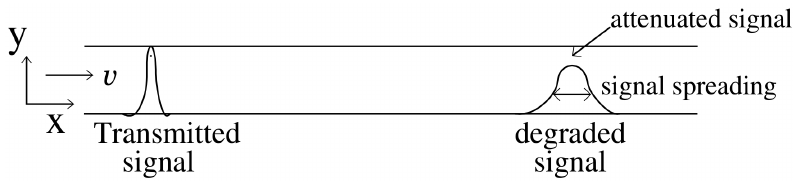
Figure 1. Concentration signal traversing microfluidic channel from Tx towards Rx degrades due to temporal spread and